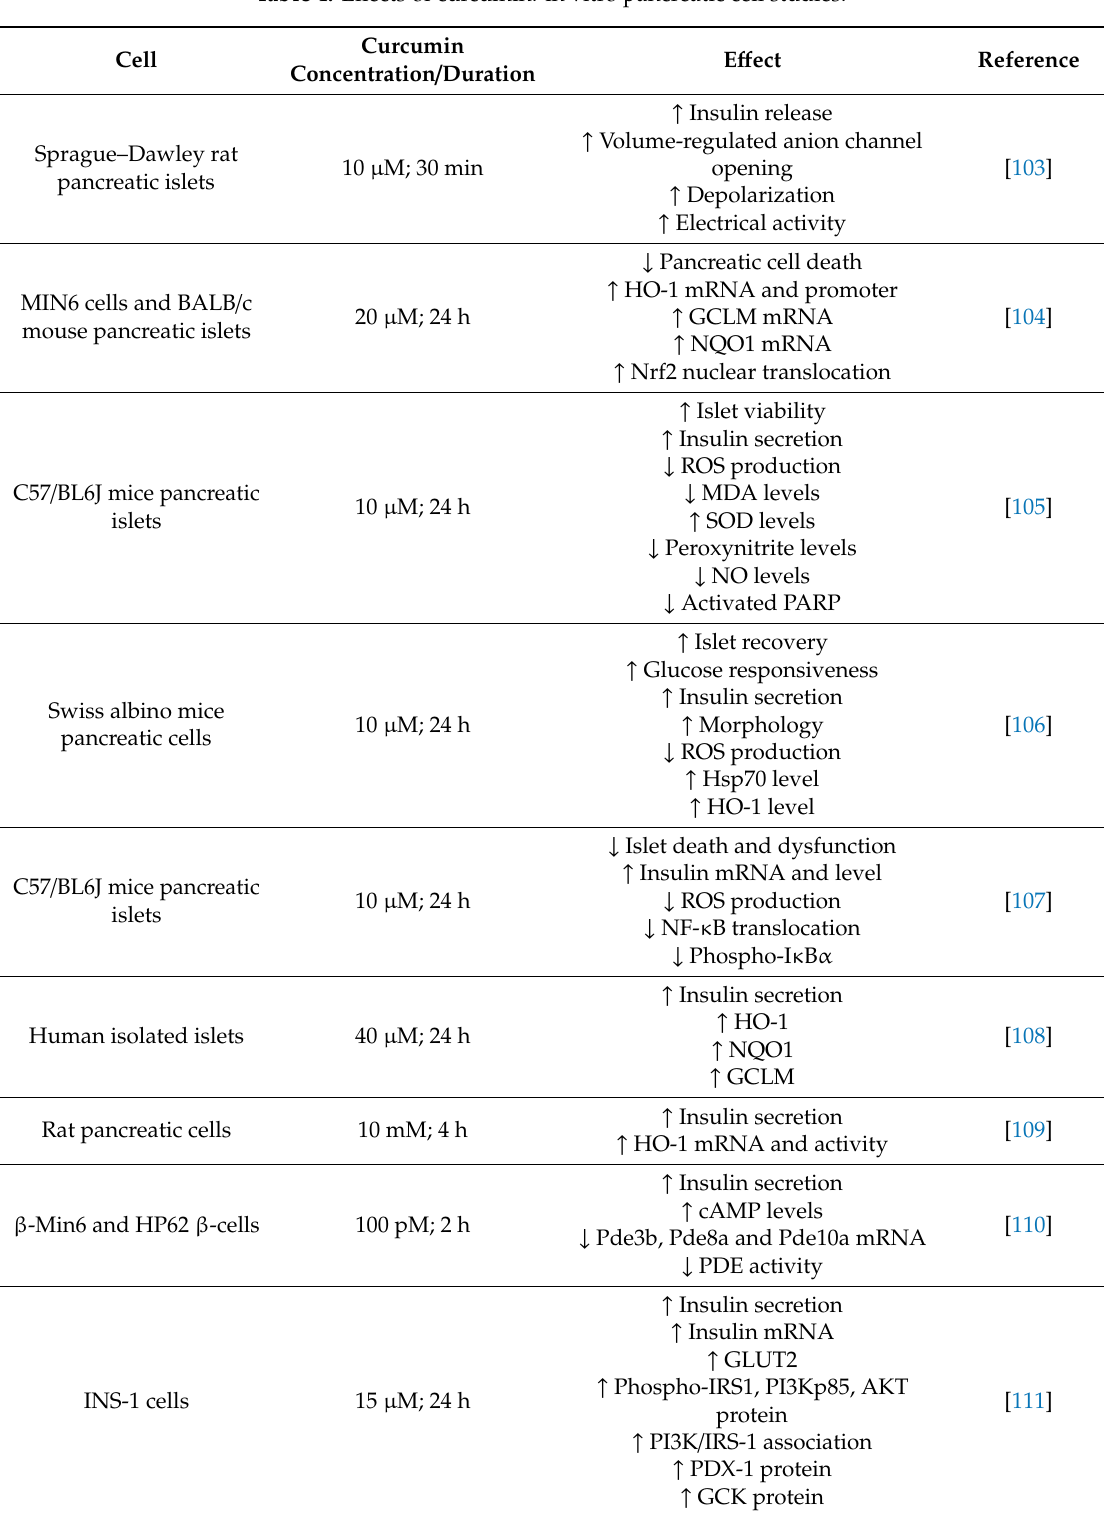
Table 4. E ff ects of curcumin: in vitro pancreatic cell